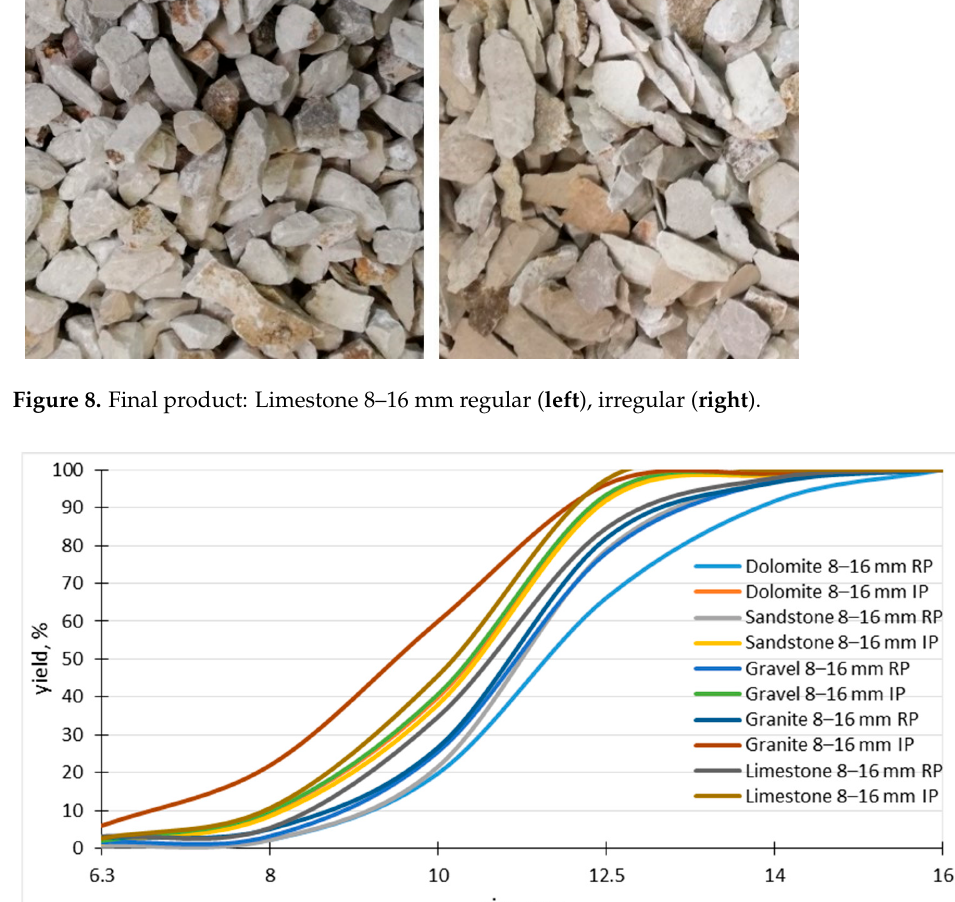
Figure 8. Final product: Limestone 8–16 mm regular ( left ), irregular ( right ).